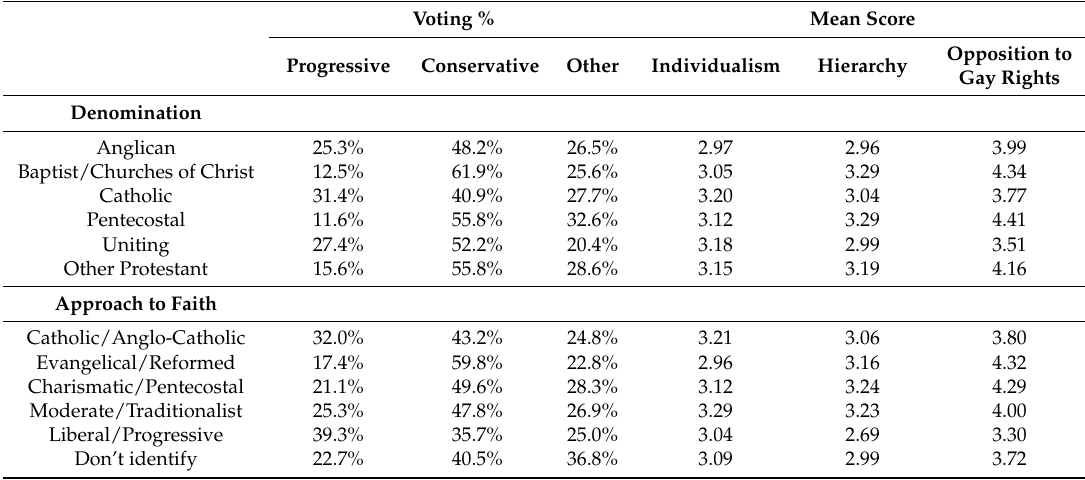
Table 4. Bivariate relationships between political measures and religion measures. Voting %